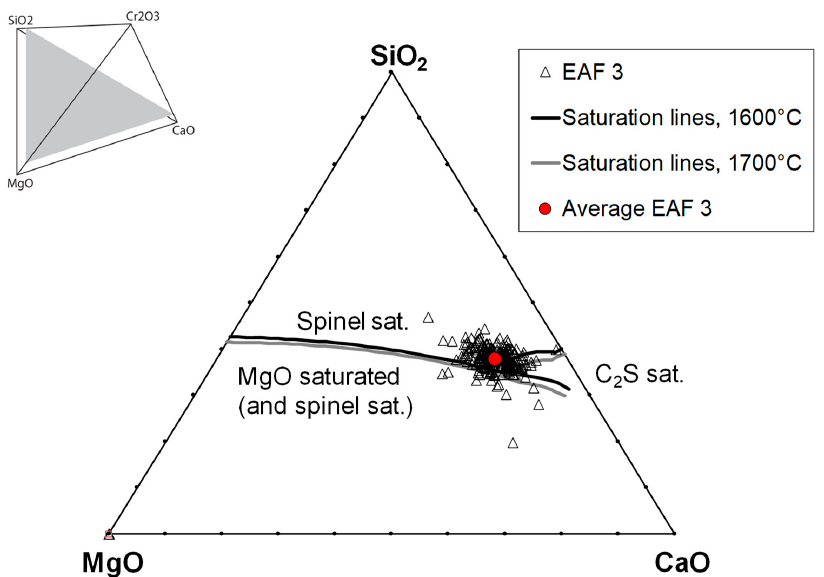
Figure 6. Slag compositions at tapping from EAF 3 versus saturation lines of MgO and C 2 S. Saturation lines are calculated by FactSage (reproduced from [13]) in the system CaO-MgO-SiO 2 -5wt.Al 2 O 3 -3~10wt.Cr 2 O 3 at 1600 °C and 1700 °C (see Figure 3).